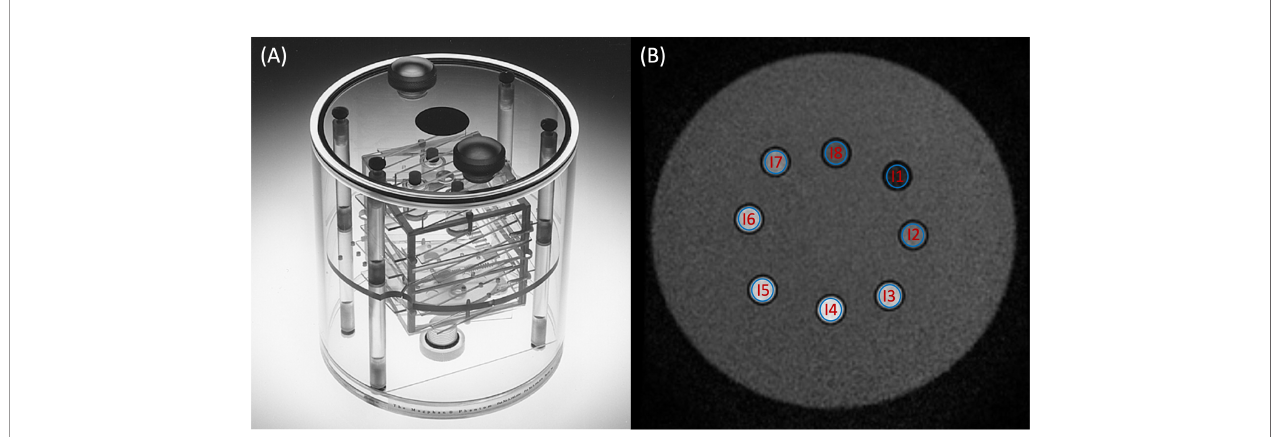
FIGURE 1 | (A) Magphan ® SMR170 (The Phantom Laboratory, Salem, NY, USA). (B) Synthetic T 2 -weighted image of the homemade phantom used in this study. The blue volumes of interest (VOIs) (B) represent the different inserts measured in this